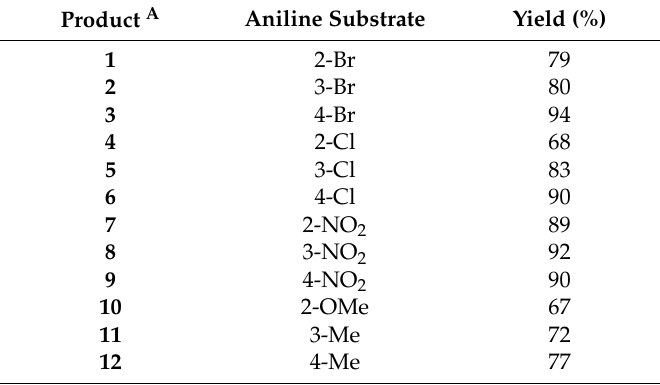
Figure 4. Flow preparation of masked hydrazine derivatives. Table 1. Flow in situ formation of hydrazine derivatives from diazonium